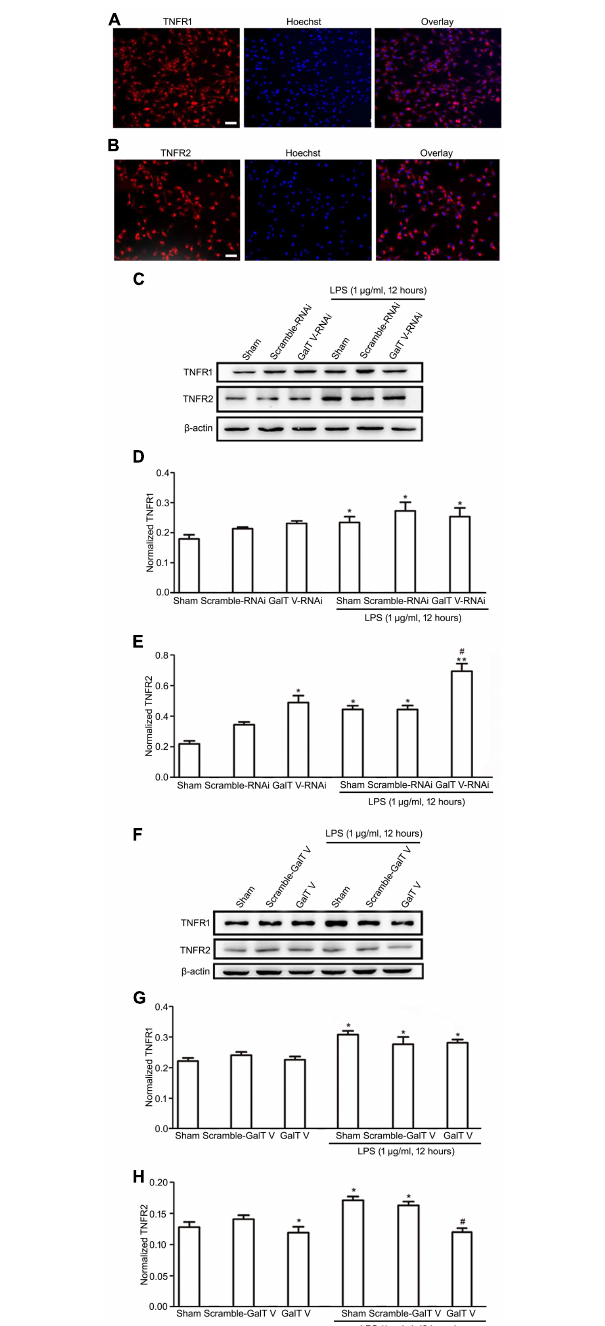
FIGURE 5 | Inhibition of β -1, 4-GalT V on the expression of TNFR2 in HAPI cells. Representative images for expression of TNFR1 (A) and TNFR2 (B) by immunostaining in HAPI cells; scale bar, 50 µ m. HAPI cells with constructions were treated with LPS (1 µ g/ml, 12 h) as indicated (C–H) . (C,F) Representative blots of TNFR1 and TNFR2. (D,G) Quantification of TNFR1 for panels (C,F), respectively. (E,H) Quantification of TNFR2 for panels (C,F), respectively. Groups significantly different from the non-treated sham group, LPS-treated sham group were marked by asterisks, hashtag respectively. No adjustments were made for multiple comparisons. Graphs show mean ± SD; n = 3; * p < 0.05, ** p < 0.01, # p <